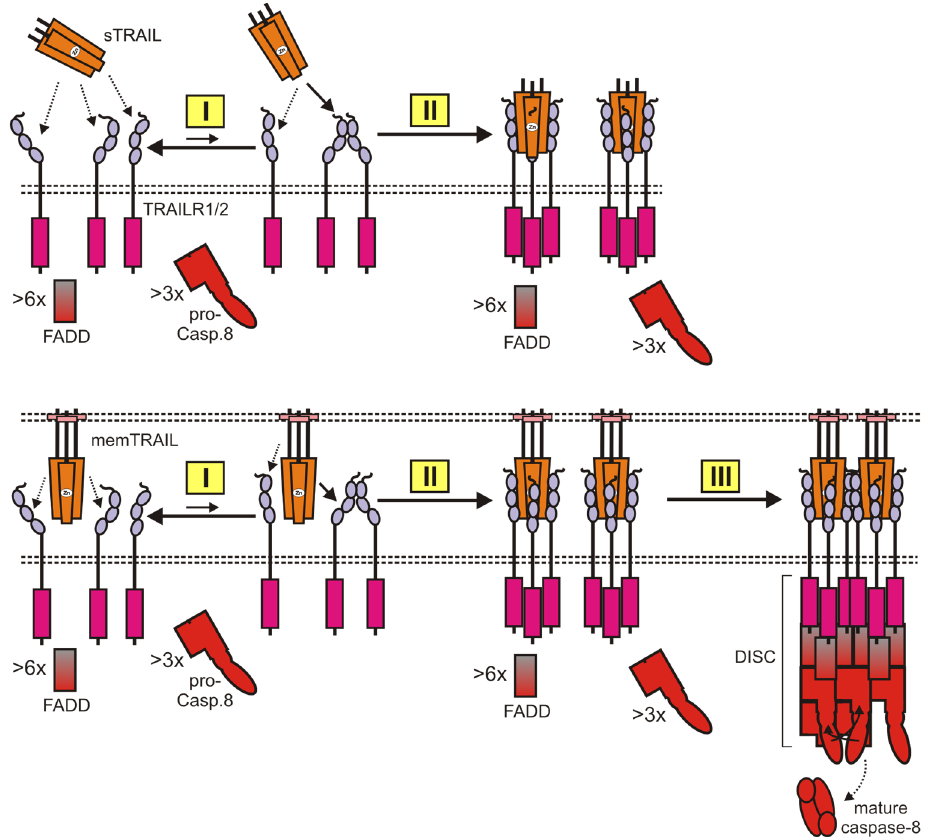
Figure 3. Two-step formation of apoptotic TRAIL death receptor-signaling complexes by TRAIL trimers. In the absence of TRAIL, TRAIL receptors interact with low affinity and thus presumably occur in a dynamic equilibrium of monomeric and dimeric (or trimeric) receptor species (I). Shown is the situation for a single TRAIL death receptor type but please note that TRAIL death receptors and TRAILR3 and 4 also interact in a homo- and heterotypic manner. A TRAIL trimer binds with high-affinity three TRAIL receptor molecules (II). The details of the assembly of this receptor complex from the unliganded receptor species are poorly understood. Evidence for its existence are the crystallographic studies and the fact that crosslinking of TRAIL trimers enhances their apoptotic activity. In the case of membrane TRAIL, trimeric TRAIL-TRAIL receptor complexes spontaneously cluster secondarily to oligomeric networks due to their high local concentration and the weak auto-affinity of TRAILRs (III). The oligomeric receptor network allows six neighboring TRAIL death receptors to form a cap together with FADD that can serve as a condensation nucleus for procaspase-8 filaments (III). In the filaments, two procaspase-8 molecules dimerize and mature by induced proximity and autocatalytic processing.